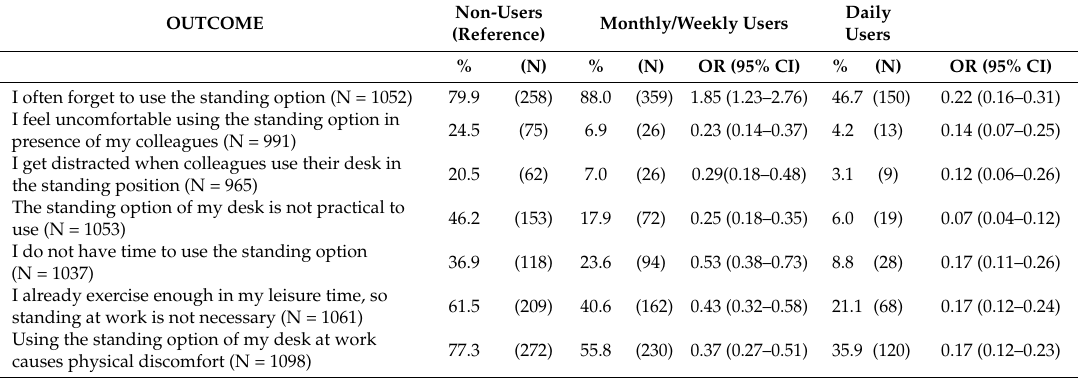
Table 5. Agreement with perceived negative perceptions of the use of the sit-stand workstation and Odds ratios (95% CI) for three user groups, with non-users as reference